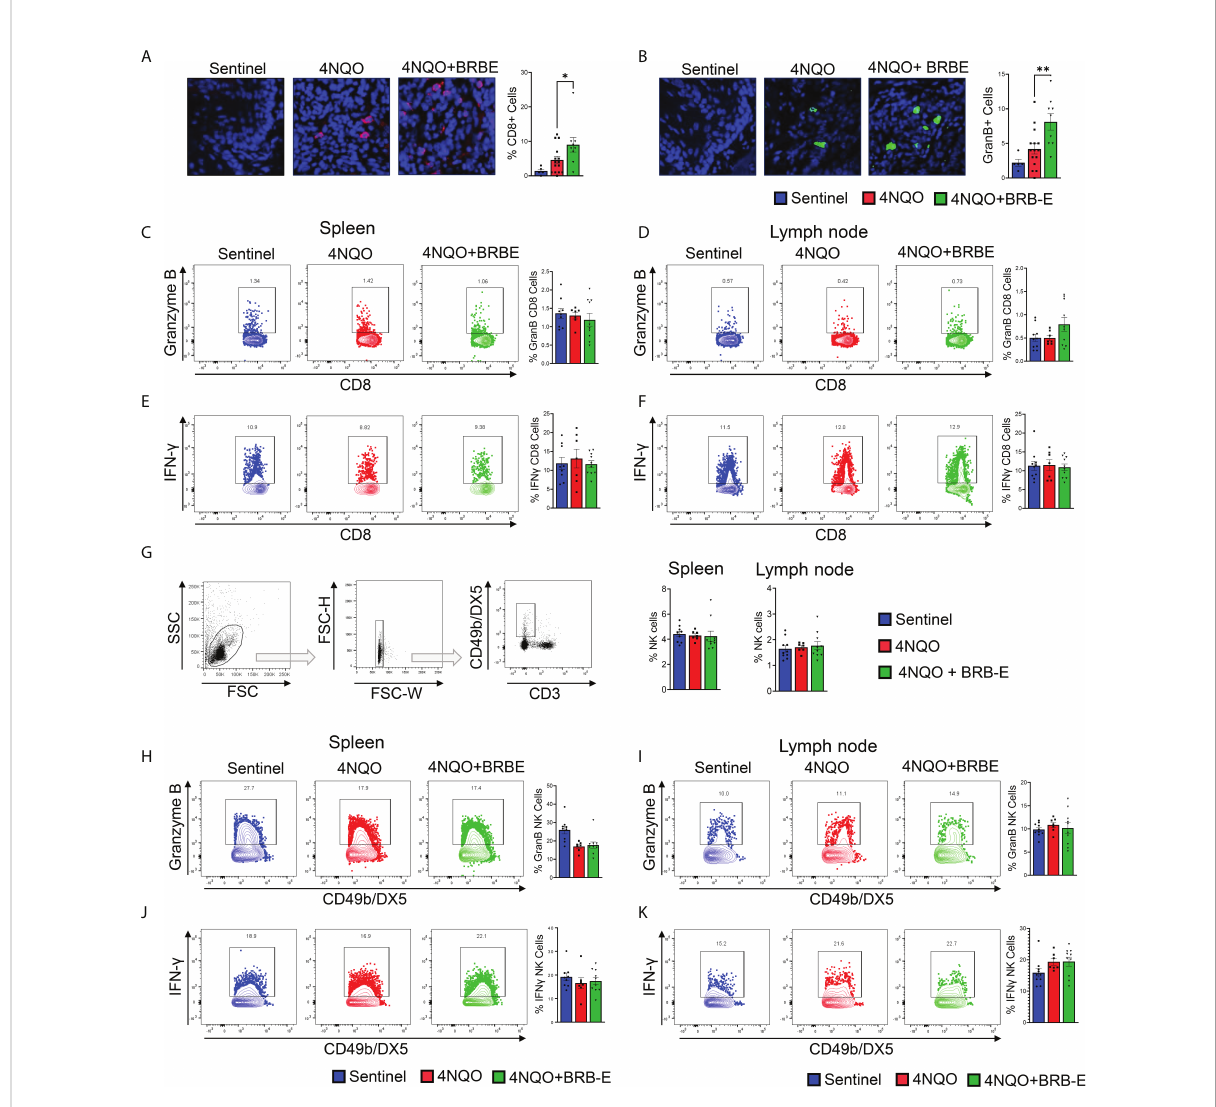
FIGURE 4 Black raspberry extract enhances antitumoral CD8 effector T-cell activity in the HNSCC tumor microenvironment. (A) Representative immuno fl uorescent images of tongue sections showing tumor-in fi ltrating CD8 + cells (red) in non-carcinogen-induced mice (sentinel) and carcinogen-induced mice fed the control AIN76 diet (4NQO) or the BRB-E-supplemented diet (4NQO+BRB-E). Tissues were counterstained with DAPI (blue) and quanti fi ed using ImageJ. (B) Representative immuno fl uorescent images of Granzyme B + cells (green) in tongue sections of non-carcinogen-induced mice (sentinel) and carcinogen-induced mice fed the control AIN76 diet (4NQO) or the BRB-E-supplemented diet (4NQO+BRB-E). Tissues were counterstained with DAPI (blue) and analyzed using ImageJ. (C and D) Representative fl ow cytometric plots and population distributions of CD8 + Granzyme B + cells in the spleens (C) and lymph nodes (D) of control feed or berry-treated tumor-bearing mice. Data are presented as percentage of total CD8 + T cells. (E and F) Representative fl ow cytometric plots and population distributions of CD8 + IFN- g + cells in the spleens (E) and lymph nodes (F) of control feed or berry-treated tumor-bearing mice. Data are presented as percentage of total CD8 + T cells. (G) Gating strategy for identi fi cation of NK cells from the draining cervical lymph nodes or spleens of HNSCC tumor-bearing or sentinel mice by fl ow cytometry. Proportions of NK cells in spleens and lymph nodes of non-carcinogen-induced mice (sentinel) and carcinogen-induced mice fed the control AIN76 diet (4NQO) or the BRB-E-supplemented diet (4NQO+BRB-E) are shown as bar graphs. (H – K) Representative fl ow plots demonstrating Granzyme B-positive staining of CD49b/DX5 + natural killer cells, isolated from spleens (H) and lymph nodes (I) of non-carcinogen-induced mice (sentinel) and carcinogen-induced mice fed the control AIN76 diet (4NQO) or the BRB-E-supplemented diet (4NQO+BRB-E). Representative fl ow plots demonstrating CD49b/DX5 + IFN- g + natural killer cells isolated from spleens (J) and lymph nodes (K) of non-carcinogen-induced mice (sentinel) and carcinogen-induced mice fed the control AIN76 diet (4NQO) or the BRB-E-supplemented diet (4NQO+BRB-E). * p -value < 0.05; ** p -value < 0.01 for comparisons of BRB-E treatment groups to the 4NQO- exposed control diet group using Student ’ s t